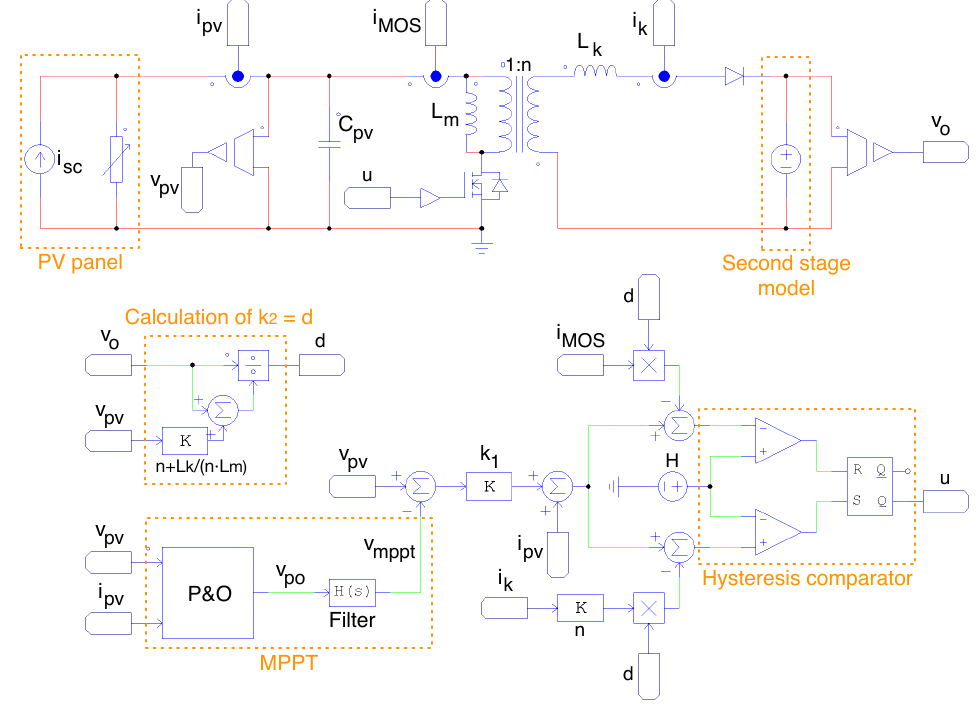
Figure 8. Circuital scheme implemented in PSIM.